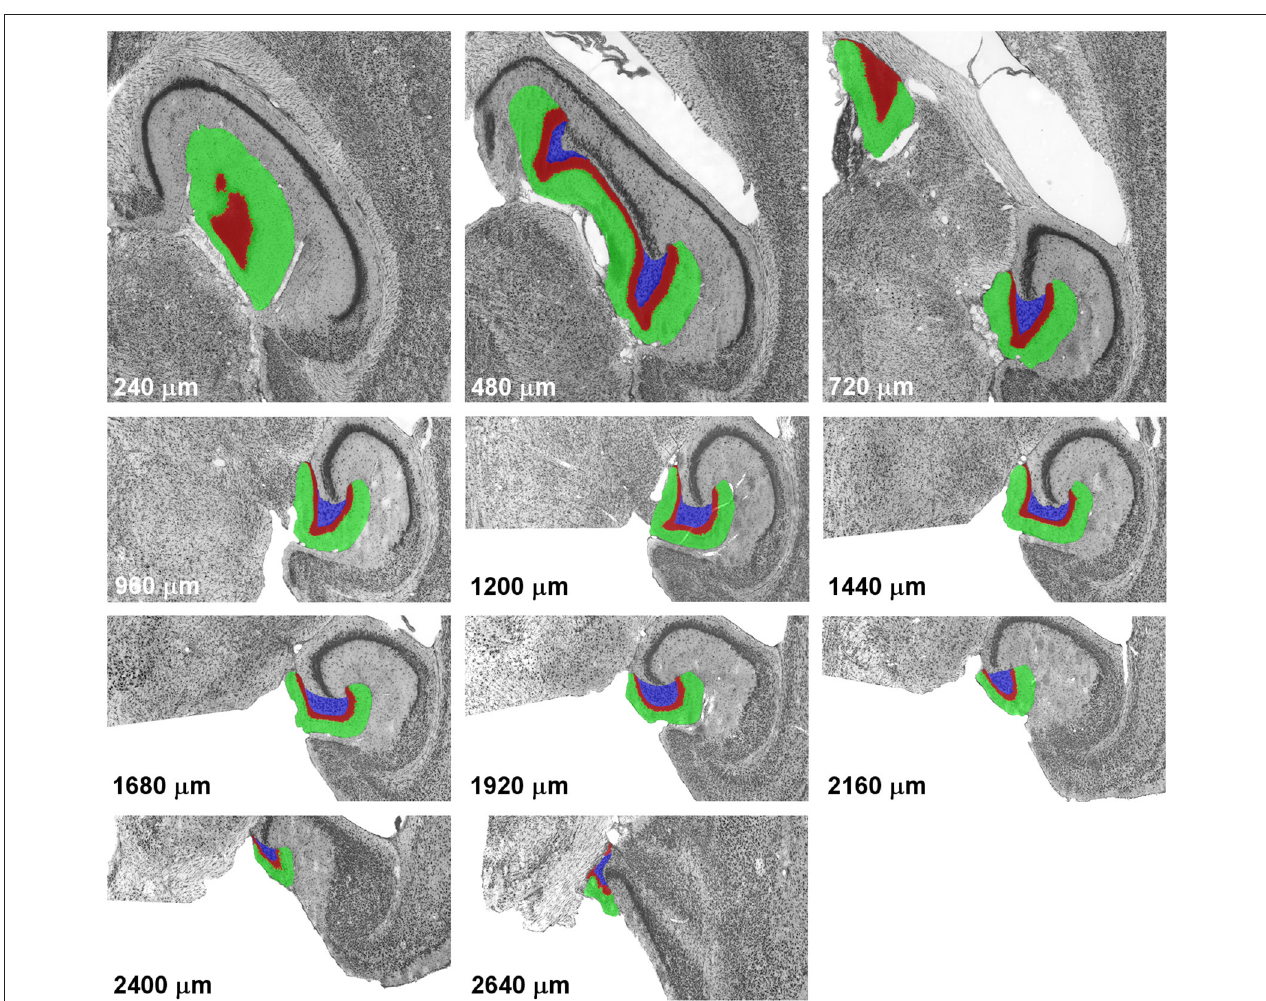
FIGURE 1 | Definitions of the dentate gyrus layers. Illustrations represent a complete sample of every 12th section of a horizontal series passing through the mouse dentate gyrus from dorsal to ventral. With the exception of the last image, alignment is maintained, with the images of levels from 960 to 2,400 µ m corresponding to the lower half of the images of more dorsal levels. The dentate molecular layer is highlighted in green, the granule cell layer in red and the hilus in